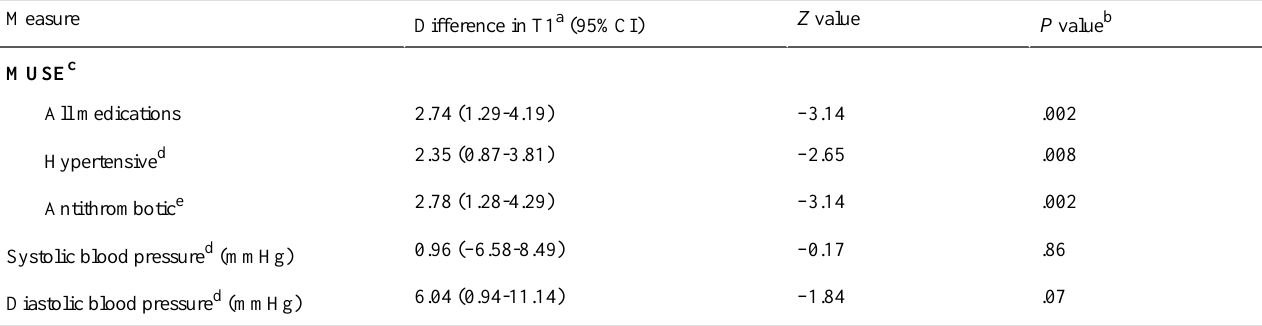
Table 4. Comparison of outcome measurement between the control and intervention